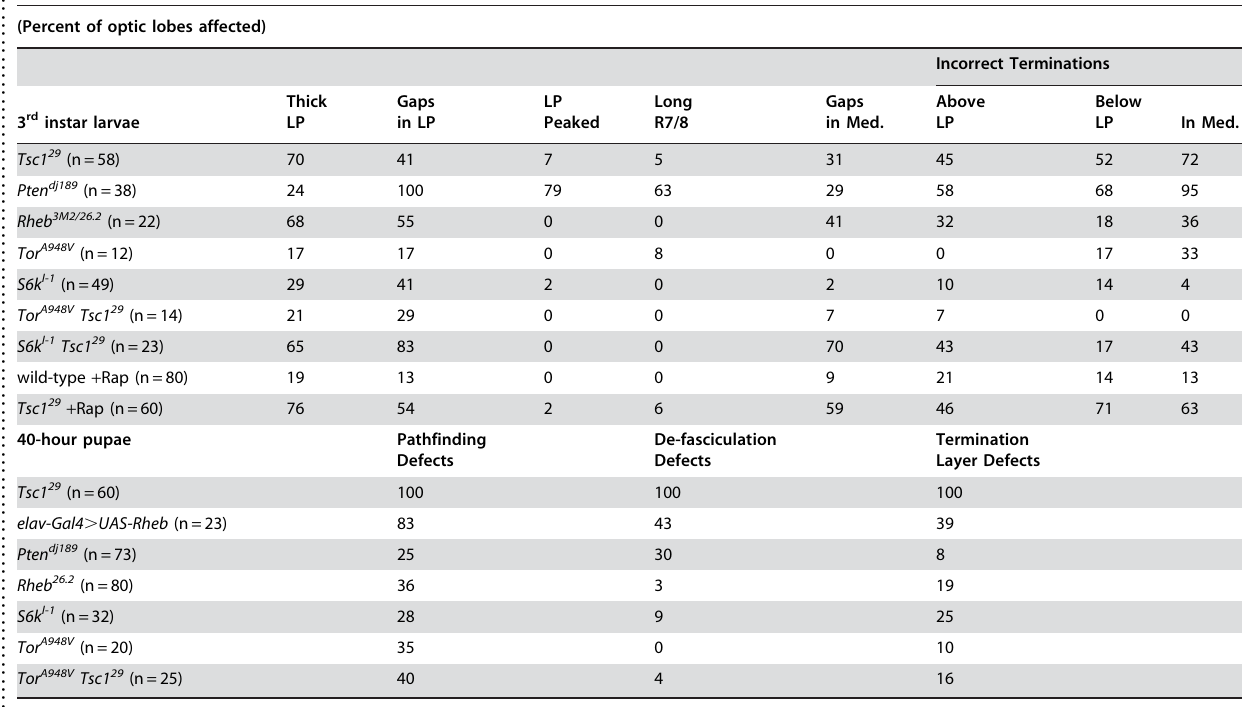
Table 1. Axon guidance defects in animals with altered Tsc-Rheb-Tor signaling .. ... .... ... ... .... ... ... .... ... ... .... ... ... .... ... ... .... ... ... .... ... ... .... ... ... .... ... ... .... ... ... .... ... ... .... ... ... .... ... ... .... ... ... . (Percent of optic lobes